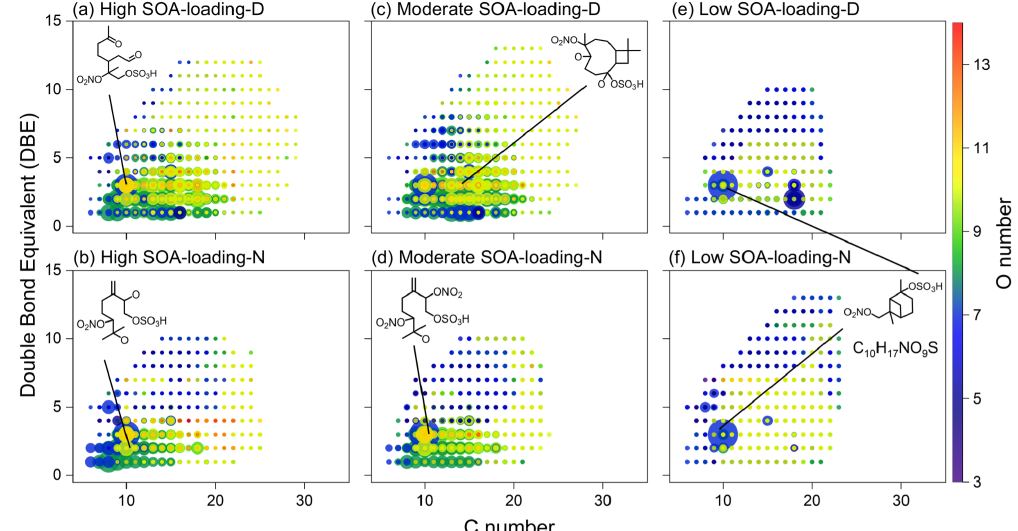
Figure 9. Double-bond equivalent (DBE) versus C number for all the CHONS compounds. The color bar and marker size denote the number of O atoms and the relative peak intensities of molecular formulae on a logarithmic scale. Note that the proposed structure is representative, not